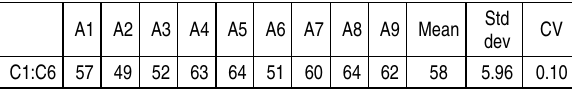
Table 43. Consortium C1:C6 performance